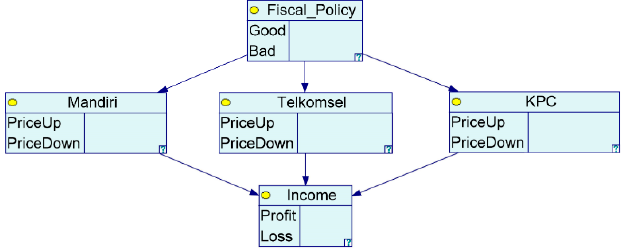
Figure 4. Investment: the relationship between the Fiscal_Policy, Stocks, and Income.